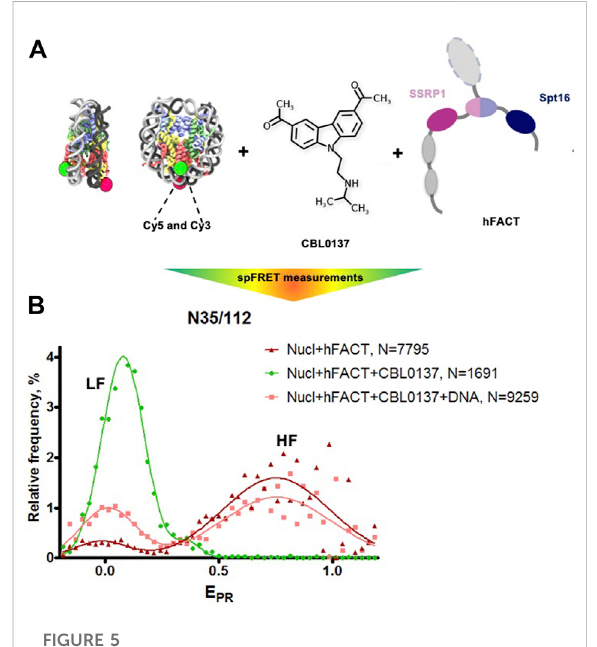
FACT and curaxin CBL0137 work synergistically and induce a large-scale nucleosome unfolding. (A) Experimental approach for analysis of nucleosome unfolding using spFRET. Mononucleosomes contained a single pair of Cy3 and Cy5dyes inthenucleosomalDNA(shownas greenandredcircles, respectively), (B) Nucleosome unfolding by FACT/CBL0137 under conditions used for electron microscopy: analysis by spFRET microscopy. Frequency distributions of FRET ef fi ciencies (E PR ) in the presence of FACT and/or CBL0137 and competitor DNA. Gaussian peaks having lower and higher FRET ef fi ciencies are indicated (LF and HF, respectively).